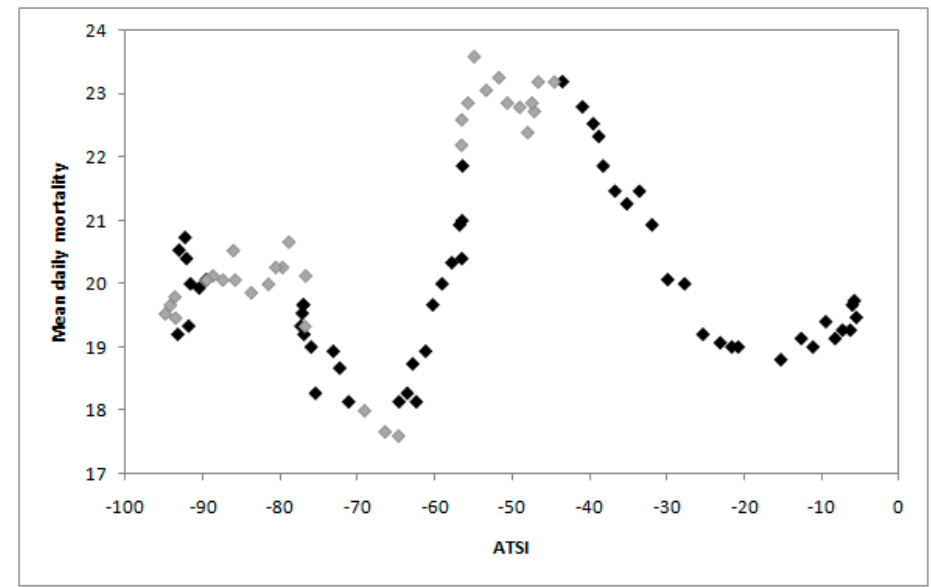
Figure 6. Plots of 15-day running means of daily mortality versus daily ATSI over the autumn of 2008 in Khabarovsk. Darker data points indicate Pearson correlation coefficients ( r ) between ATSI and mortality higher than ±0.63; lighter data points indicate r values lower than ±0.63.